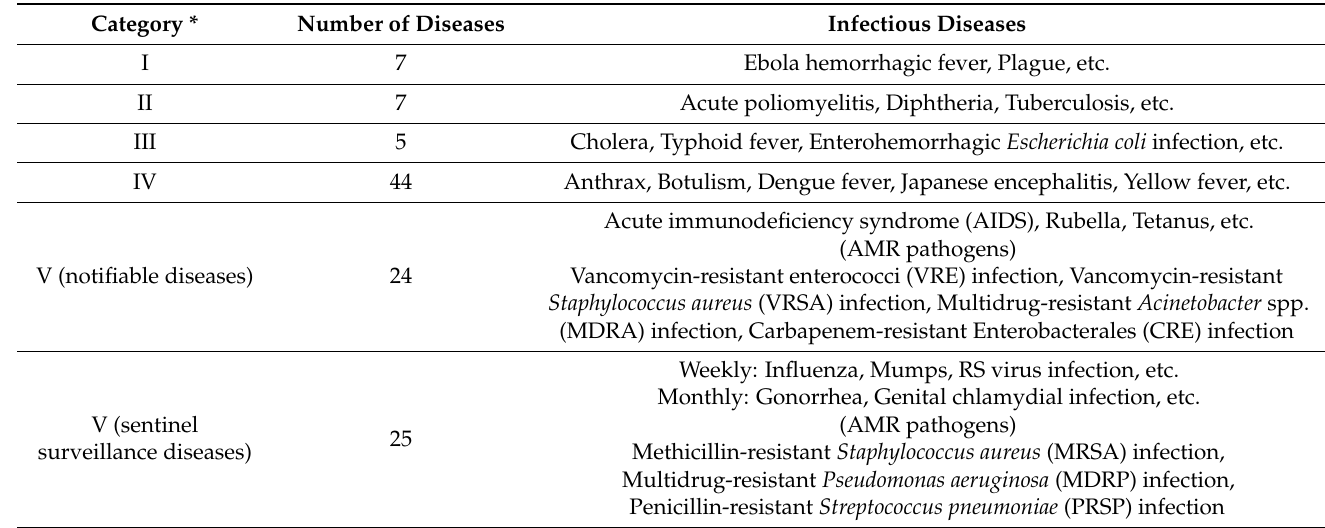
Table 1. Disease categories of the National Epidemiological Surveillance of Infectious Diseases